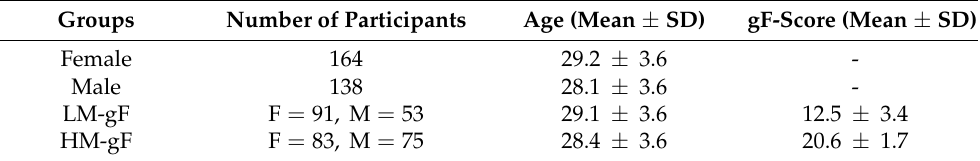
Table 1. Demographics and participant distribution results.